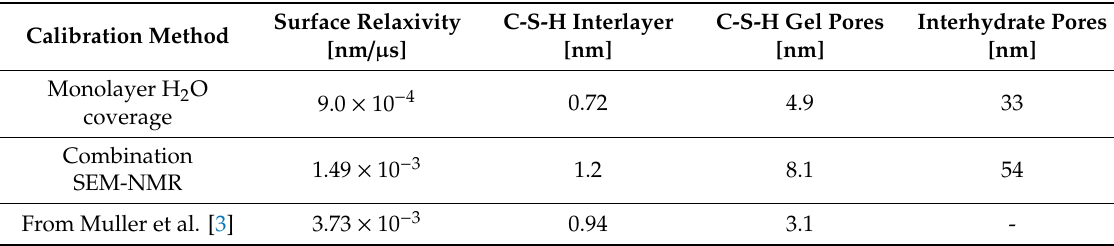
Table 3. Surface relaxivity and pore sizes calibrated via monolayer H 2 O coverage and SEM–NMR combination compared to literature